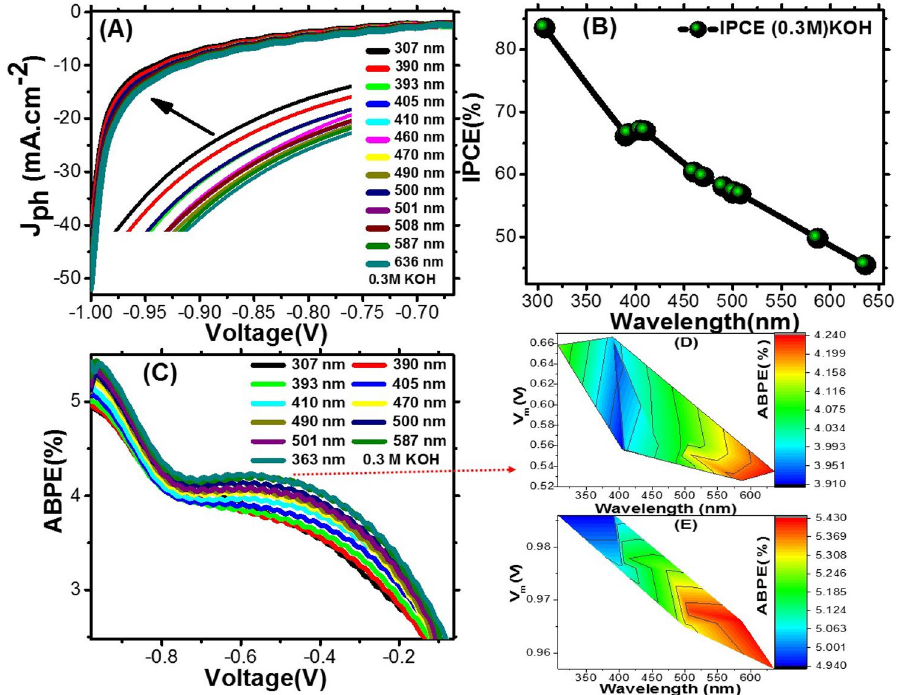
Figure 11. Effect of optical filters wavelength on J ph -voltage characteristics ( A ); IPCE% vs. wavelength in − 1 V ( B ), ABPE% vs. the applied voltage at different wavelengths ( C ), and color fill contours of the two ABPE% maximum values in the optimized voltage at different wavelengths utilizing T-LDH/PbI 2 NC electrode in 0.3 M KOH ( D , E